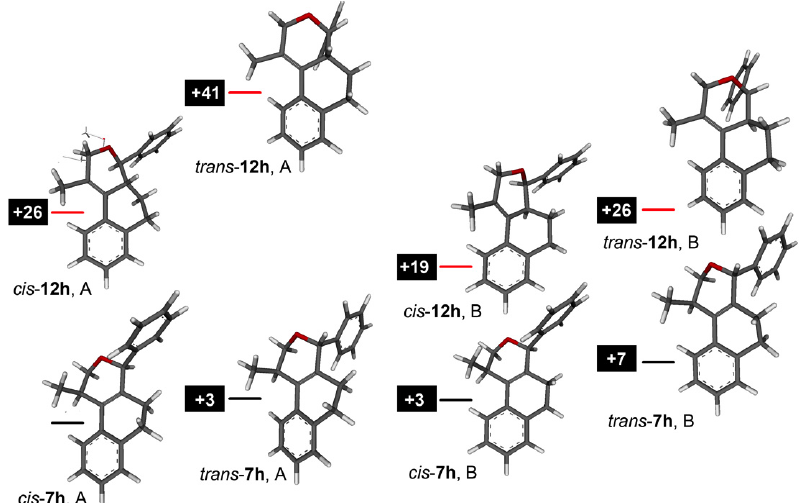
Figure 7. Energy diagram comparing products 7h and 12h in two different conformations of ring C.